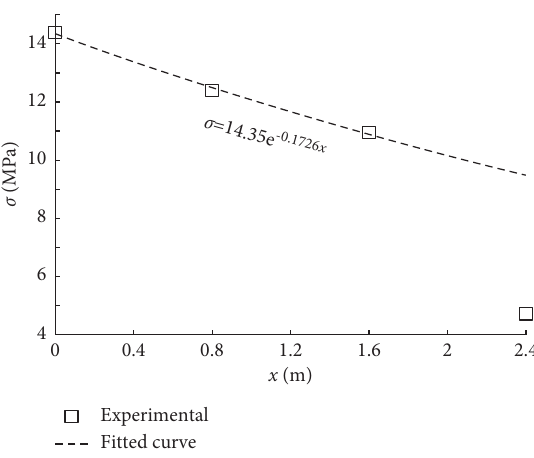
Figure 12: Impact stress attenuation curve in the drill stem. Table 3: The input parameters of drilling tool impact